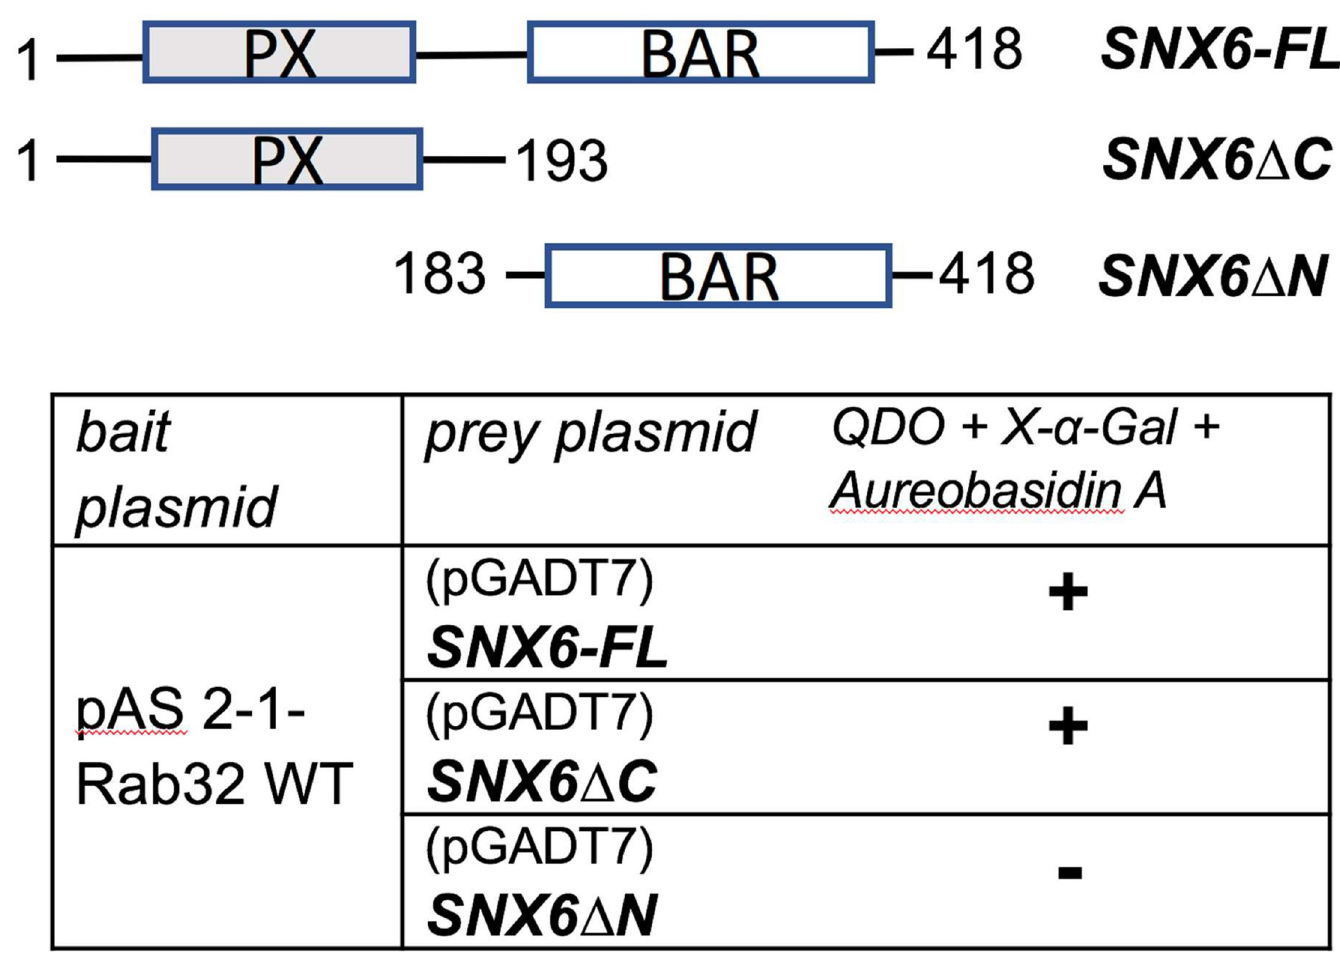
Fig 1. Rab32 interacts with the PX domain of SNX6. Rab32-interacting domains were identified by constructing different plasmids containing either full length SNX6 or the BAR (SNX6 Δ N) or PX (SNX6 Δ C) domains only. Co-transformations were peformed in the yeast strain Gold with the indicated plasmids. Colony growth on QDO plates and blue color indicates that the proteins interact (+), n � 3 independent